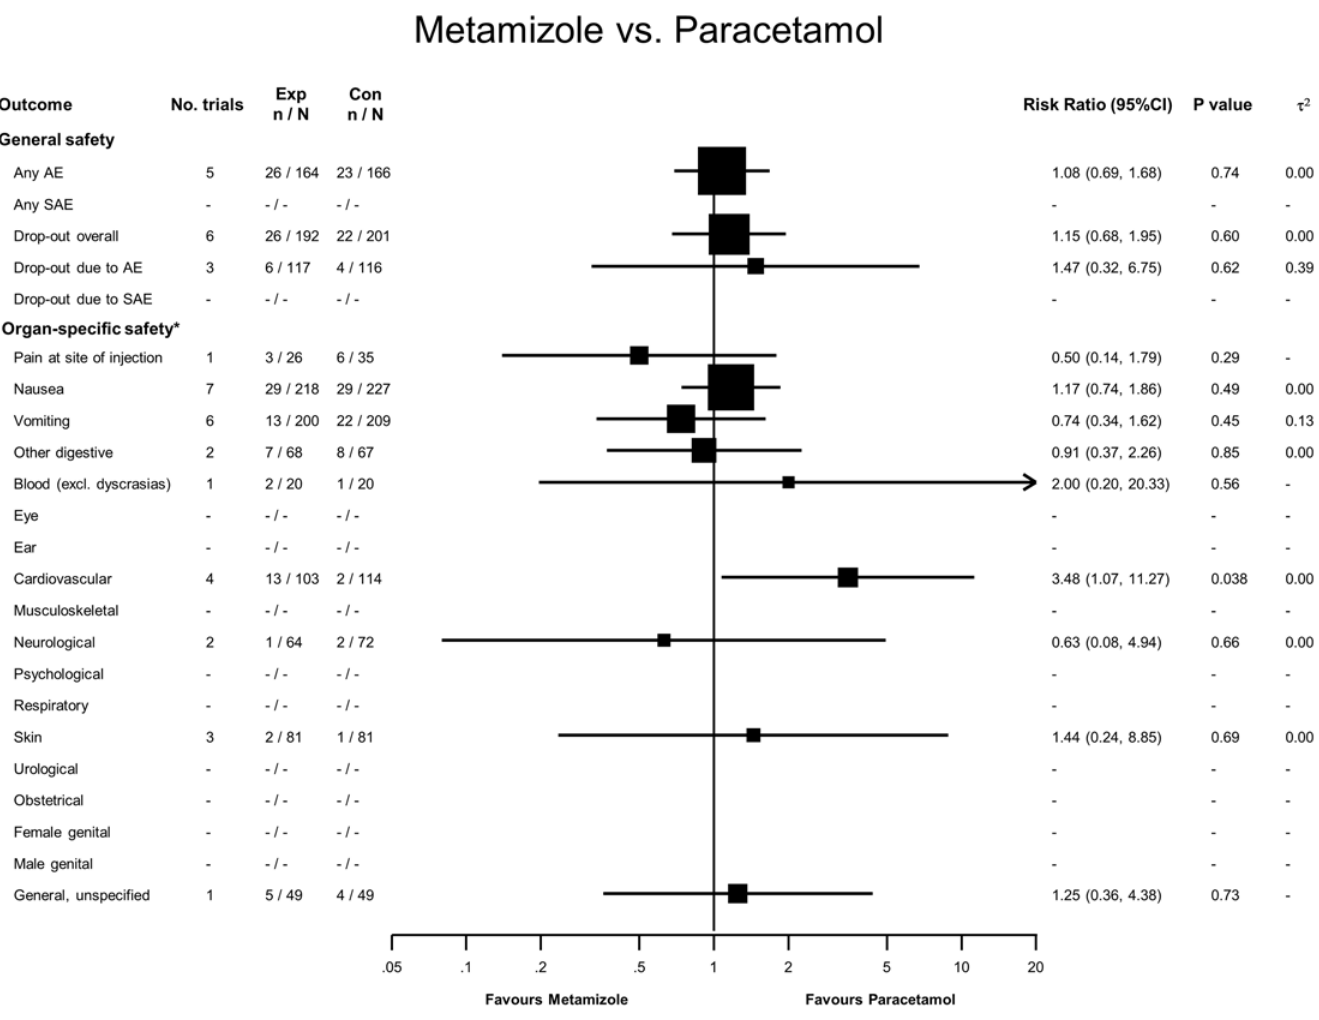
Fig 3. Forest plot — Metamizole versus Paracetamol. Categories according to the International Classification of Primary Care (see Methods section and [13]). Results from single studies are of limited interpretability but are displayed for the sake of completeness. RR = risk ratio. AE = adverse events. SAE = serious adverse events.